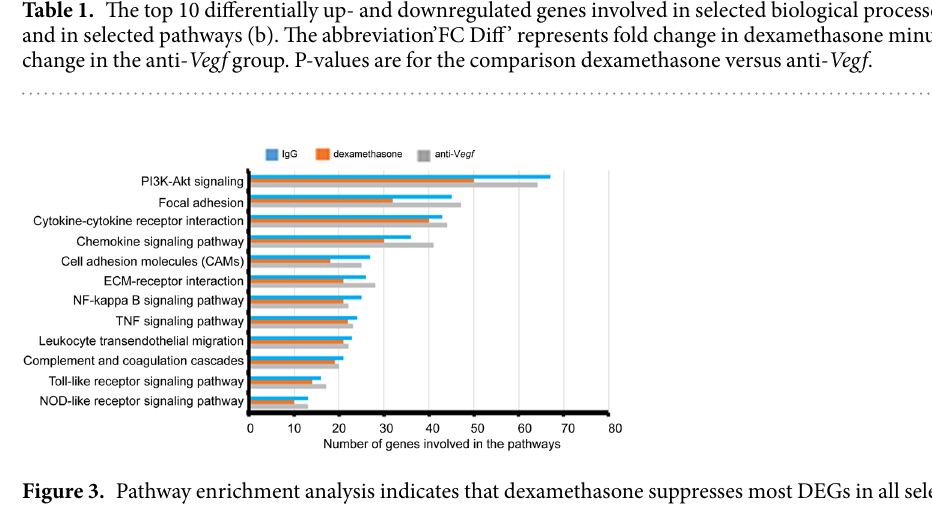
Figure 3. Pathway enrichment analysis indicates that dexamethasone suppresses most DEGs in all selected inflammatory and angiogenesis pathways, relative to IgG and anti- Vegf